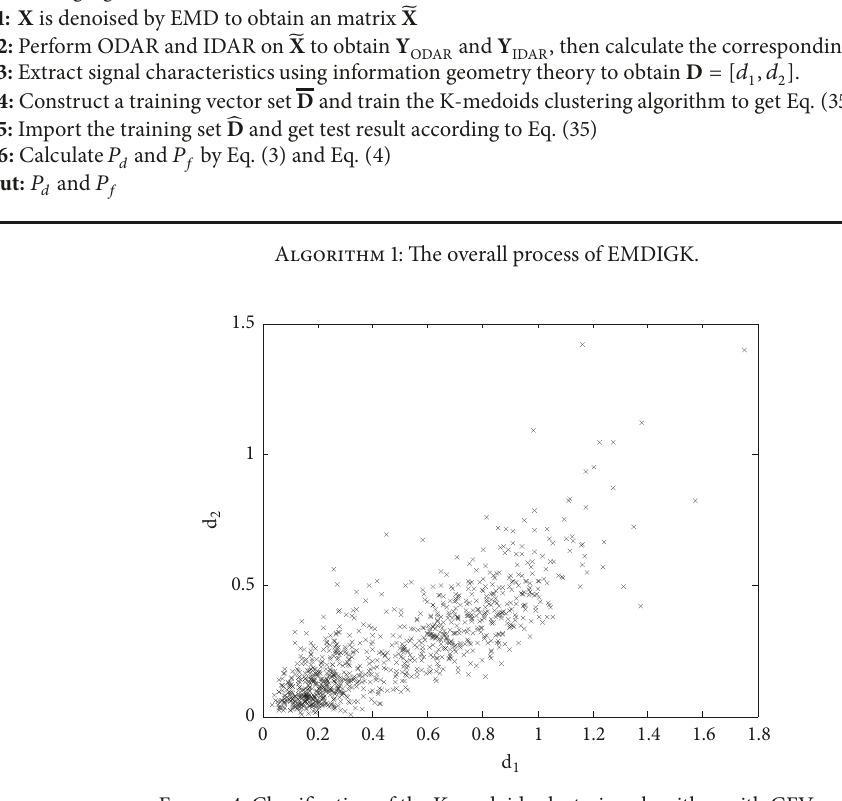
Algorithm: EMDIGK Input: Sensing signal matrix X